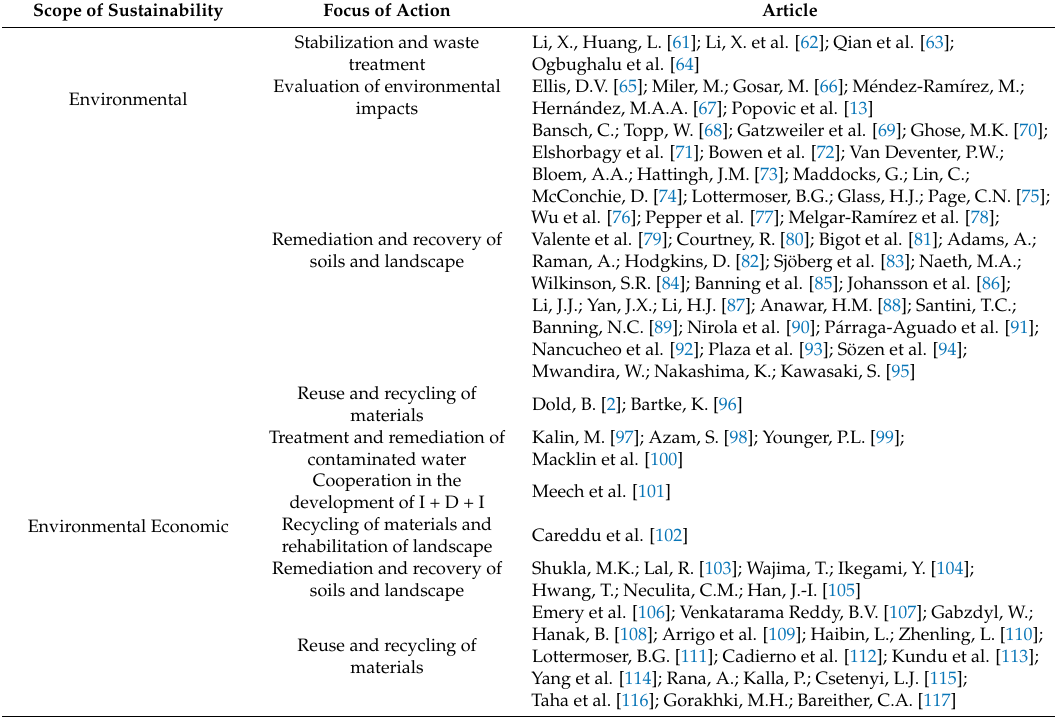
Table 12. Articles published on the sustainable management of mine waste